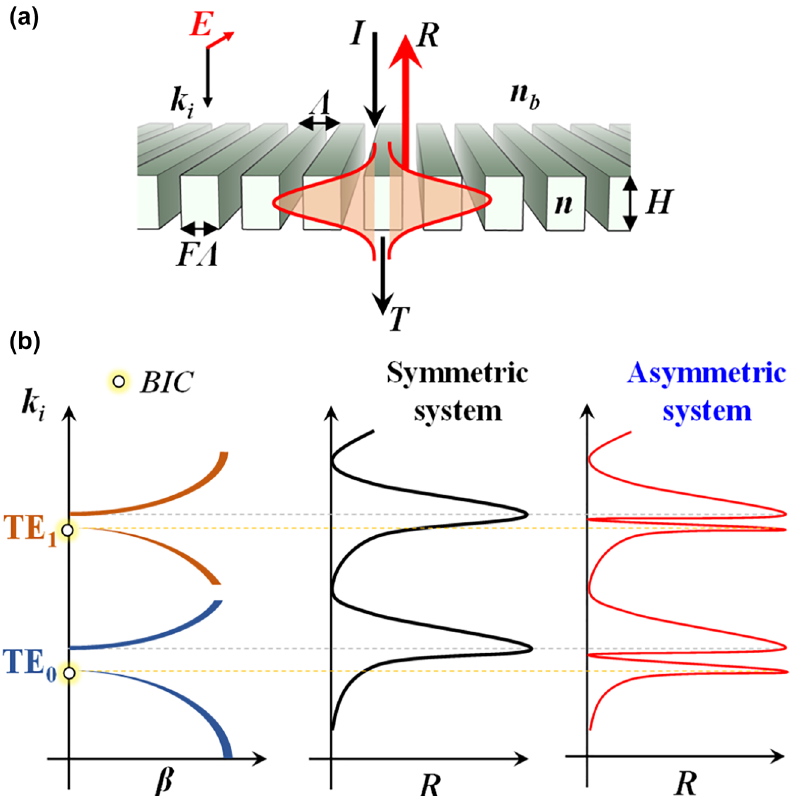
Figure 1: Lattice resonances in symmetric and asymmetric optical systems. (a) A schematic view of the simplest subwavelength resonance system. The , n ). When phase matching occurs model lattice has thickness ( H ), fill factor ( F ), period ( Λ ), and refractive indices of background and lattice material ( n b between evanescent diffraction orders and a waveguide mode, a guided-mode resonance occurs. I , R , and T denote the incident wave with wavelength, reflectance, and transmittance, respectively. (b) A schematic dispersion diagram of a resonant lattice at the second stop band. For a symmetric lattice, the leaky edge supports guided-mode resonant radiation while the non-leaky edge hosts a non-radiant bound state. This picture applies to both TE (electric field vector normal to the plane of incidence and pointing along the grating grooves) and TM (magnetic field vector normal to the plane of = 2 π / λ , and 𝛽 denotes a propagation constant of a leaky incidence) polarization states. Here, the grating vector has magnitude K = 2 π / Λ , k i